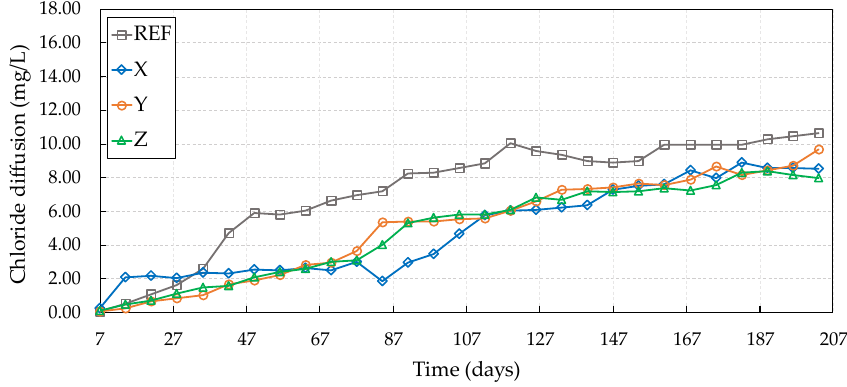
ff usion after six wet–dry Figure 10. Chloride diffusion after six wet–dry cycles. Figure 10. Chloride di